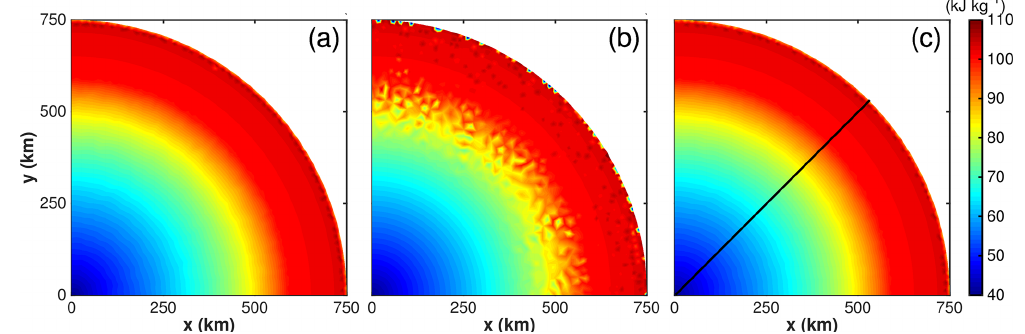
Figure 4. Simulated enthalpy (kJkg − 1 ) for the ice dome experiment with l min = 10km and k 2 = 50am − 1 . (a) SUPG maxK, (b) SUPG minK, and (c) ASUPG. Black line in (c) indicates the location of the cross section shown in Fig. 5.